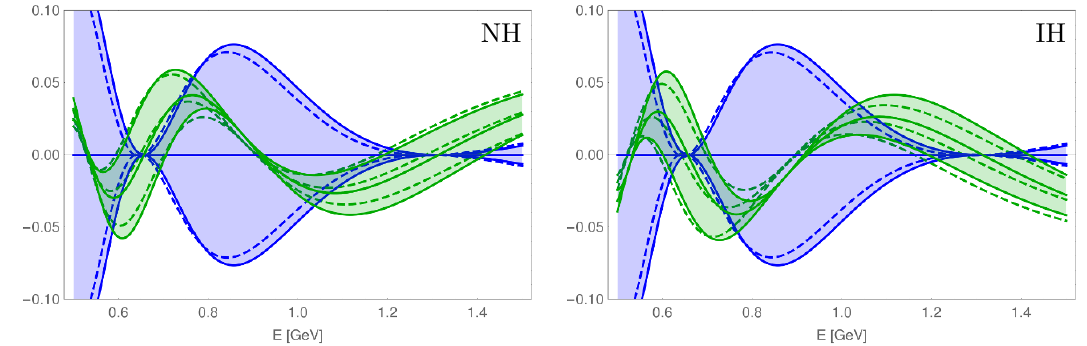
Figure 9 . Zoom of (cid:12)gure 3 at low E , showing A CPT